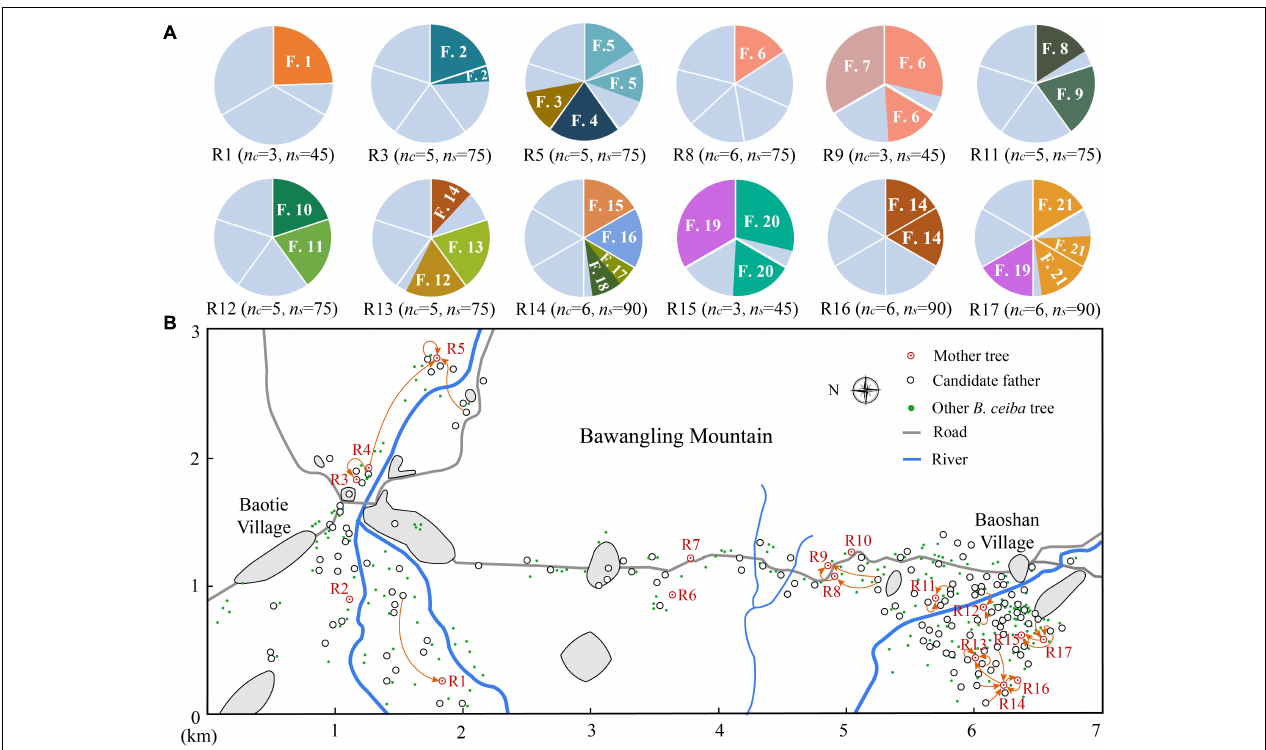
FIGURE 2 | Pollen flow and multiple paternity of B. ceiba . (A) Composition of fathers in individual trees. n c , number of capsules analyzed in each tree; n s , number of seeds analyzed in each tree; F, seedlings assigned father; different colors in the pie chart represent seedlings assigned to different fathers and gray color indicates seedlings not assigned to a pollen parent within the study population. (B) Pollen flow of B. ceiba individuals in the study stand. The gray area represents